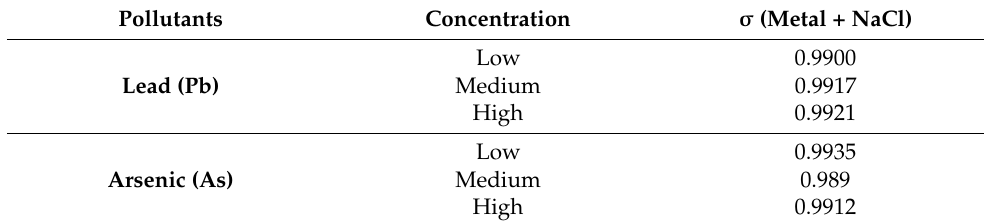
Table 3. Calculation of reflection coefficients.